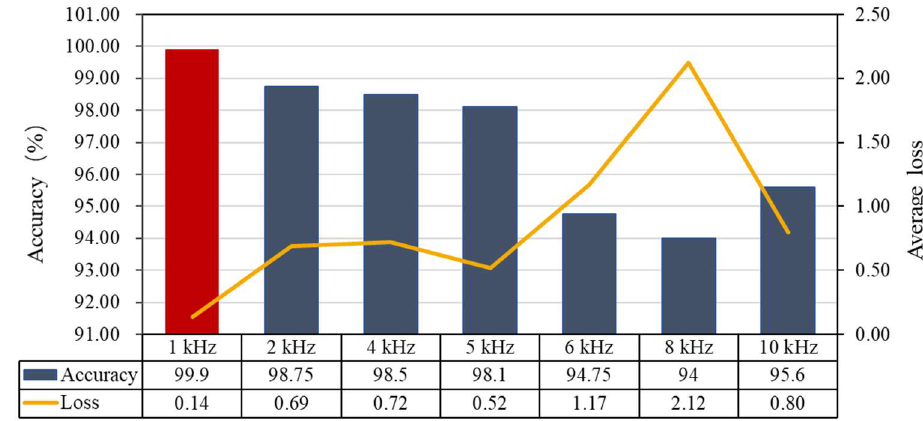
Figure 20. The accuracy and loss of dataset B.